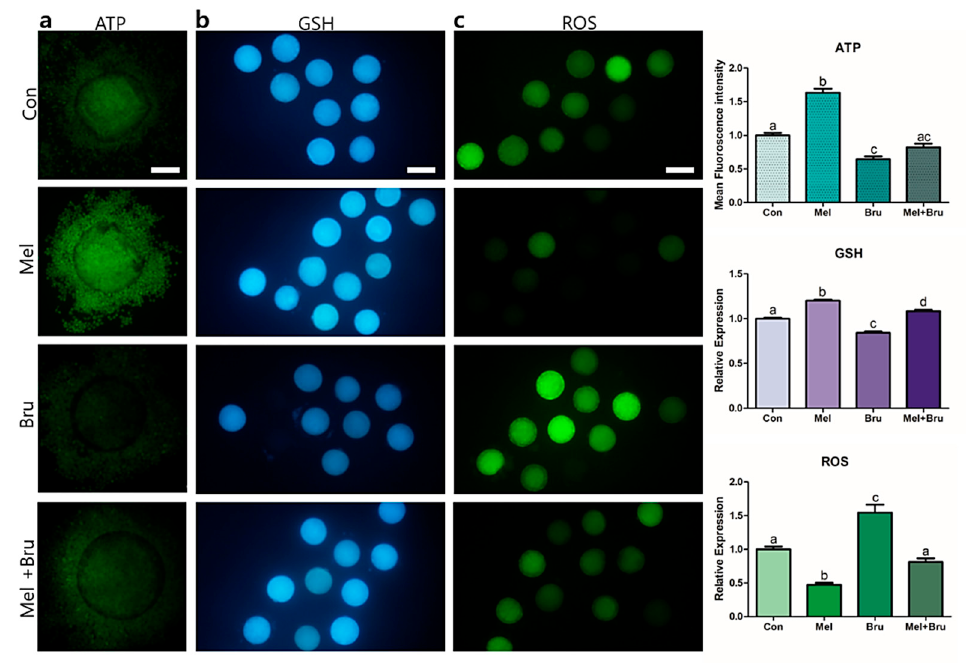
Figure 3. Determination of ATP production and Glutathione (GSH) and reactive oxygen species (ROS) levels in porcine oocytes. The four experimental groups (control, melatonin, brusatol, and co-treatment) showed significant di ff erences in ( a ) ATP production (BODIPY staining), ( b ) GSH level (CellTracker Blue staining), and ( c ) ROS level (H2DCFDA fluorescence). Bars with letters indicate significant di ff erences ( p < 0.05). Figure 3a: 200 × magnification; bars indicate 50 µ m. Figure 3b,c: 100 × magnification; bars indicate 100 µ m. Con: control, Mel: melatonin, Bru: brusatol, and Mel + Bru: melatonin + brusatol. At least three replicates were performed for each experiment.